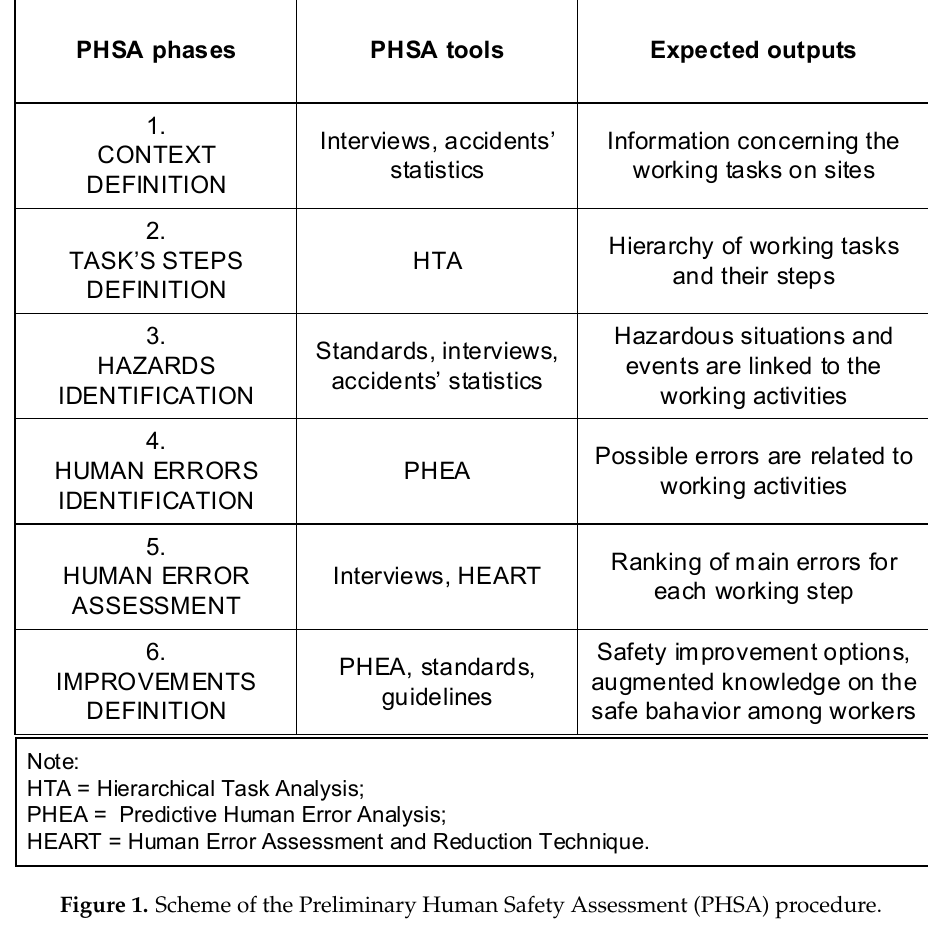
Figure 1. Scheme of the Preliminary Human Safety Assessment (PHSA) procedure.